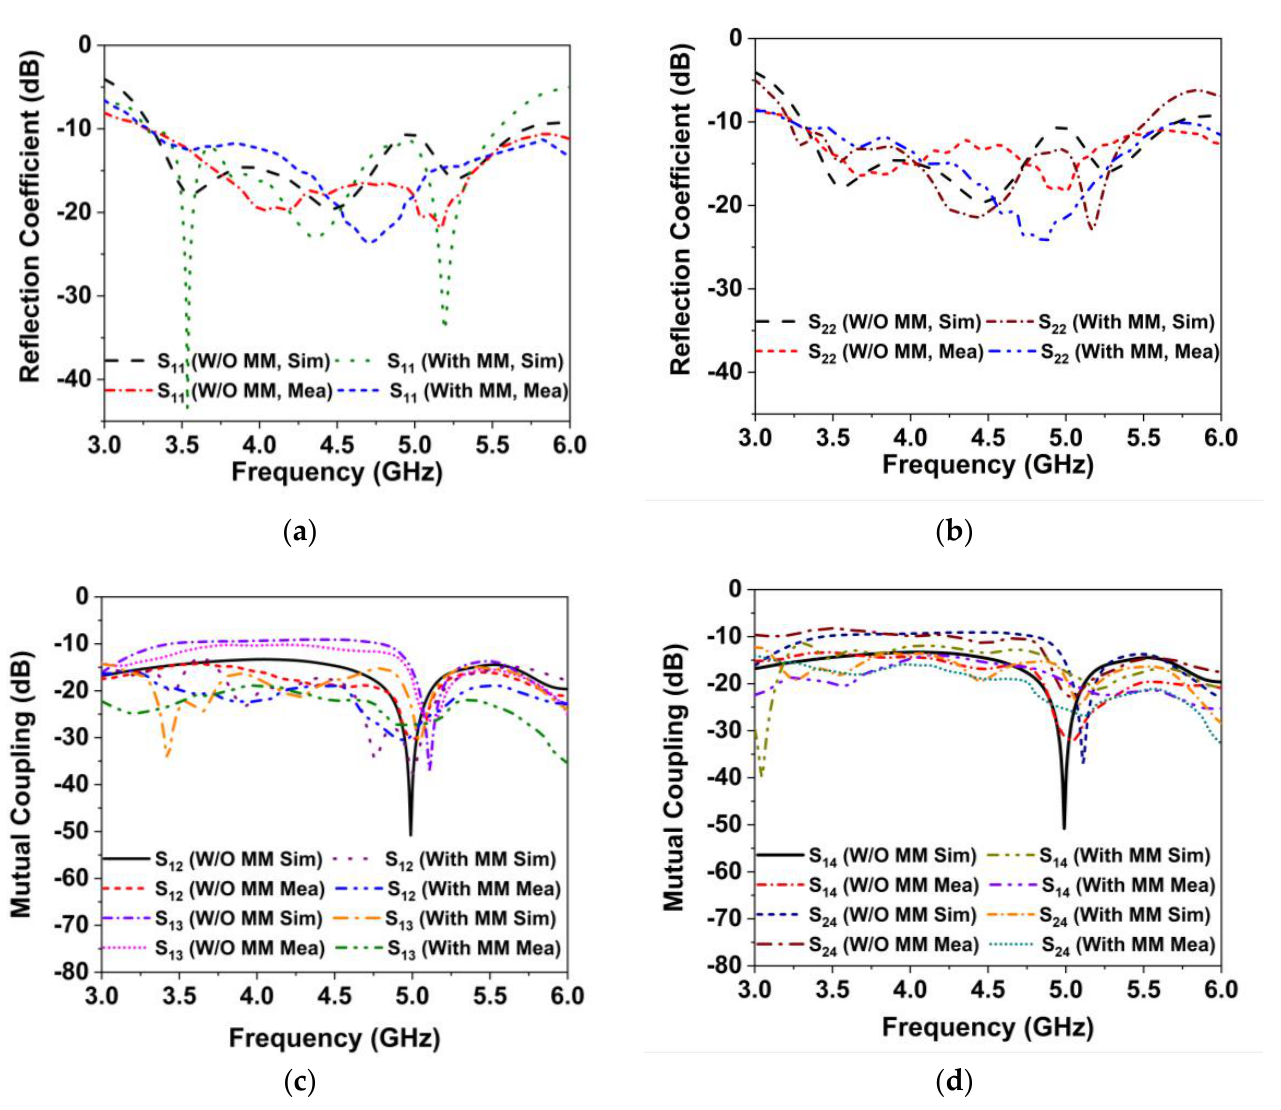
Figure 8. Simulated and tested scattering matrix characteristics of the developed MIMO system without and with MM ( a ) | S 11 | ( b ) | S 22 | ( c ) | S 12 , S 13 | and ( b ) | S 14 , S 24 | . To clarify the isolation mechanism of the developed MM reflector, the surface current distribution and electric field distribution of the designed MIMO and the MIMO with the MM antenna are investigated at 4.5 GHz, as depicted in Figures 9 and 10. A significant coupling current is transferred to the nearest antennas, increasing the near-field mutual coupling effect between MIMO antennas (Figure 9a). After using the MM reflector, the near-field coupling current is concentrated in the MM unit cells, where the current traverses in an antiparallel fashion in one half of the ring and the following rings, as shown in Figure 9 (b). In addition, the residual edge currents of the adjacent MIMO antennas are in an antiparallel cancelation fashion. Therefore, the near-field coupling current between the adjacent antennas is suppressed, resulting in high isolation. Figure 10 shows the electric field (E-field) distributions for the MIMO and the MIMO with the MM antenna, where antenna 1 is excited. A strong coupled electric field is found in antennas 2, 3, and 4 of the MIMO system when the MM is absent (Figure 10a). After employing the MM